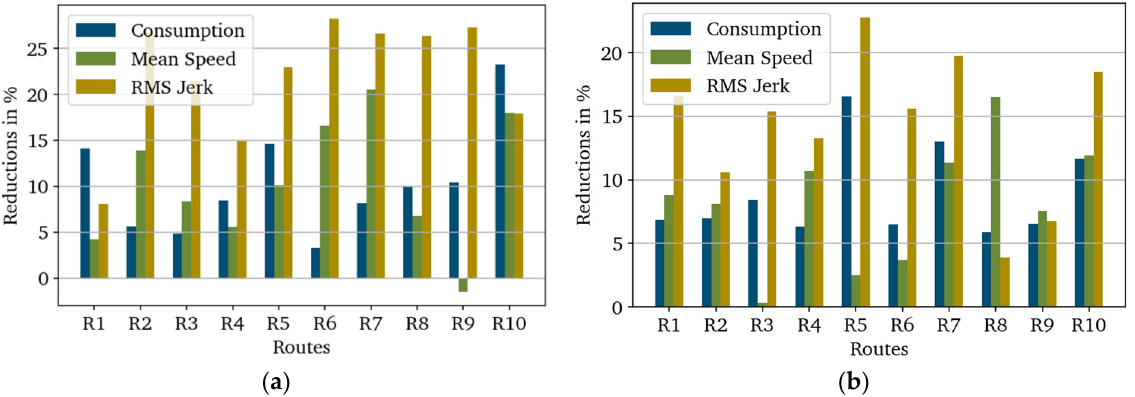
Figure 14. Reductions of performance indicators with the proposed control C p compared to the reference C ref for BEV-1. The results are shown for ( a ) the rush hour and ( b ) the off-peak period. Table 4. Summary of the performance indicators.